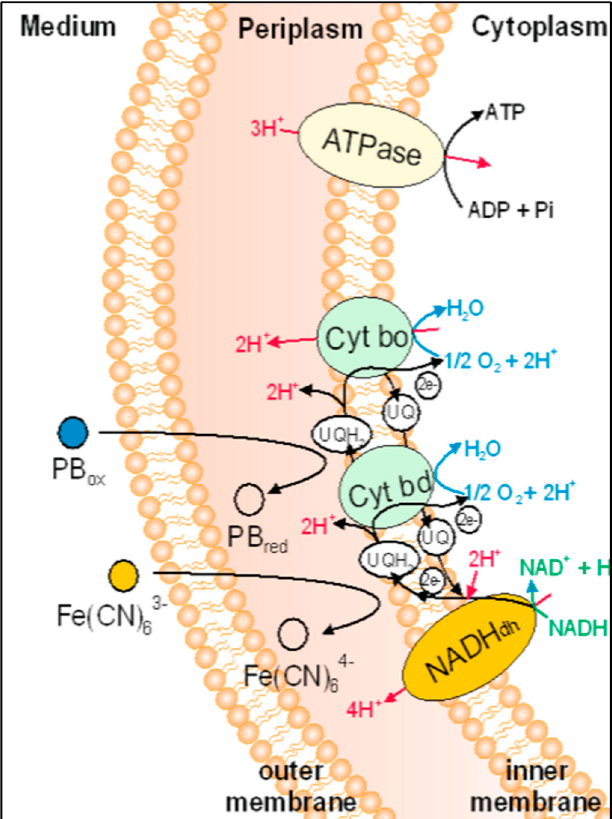
Figure 1. Scheme of the electron transport chain of E. coli